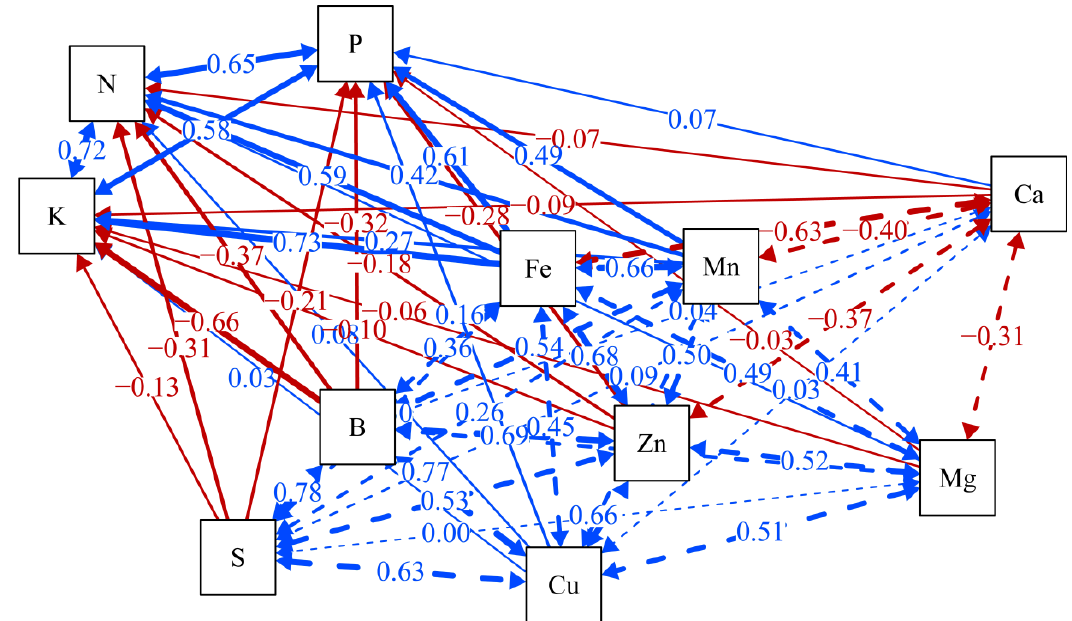
Figure 12. Path analysis of absorption of different